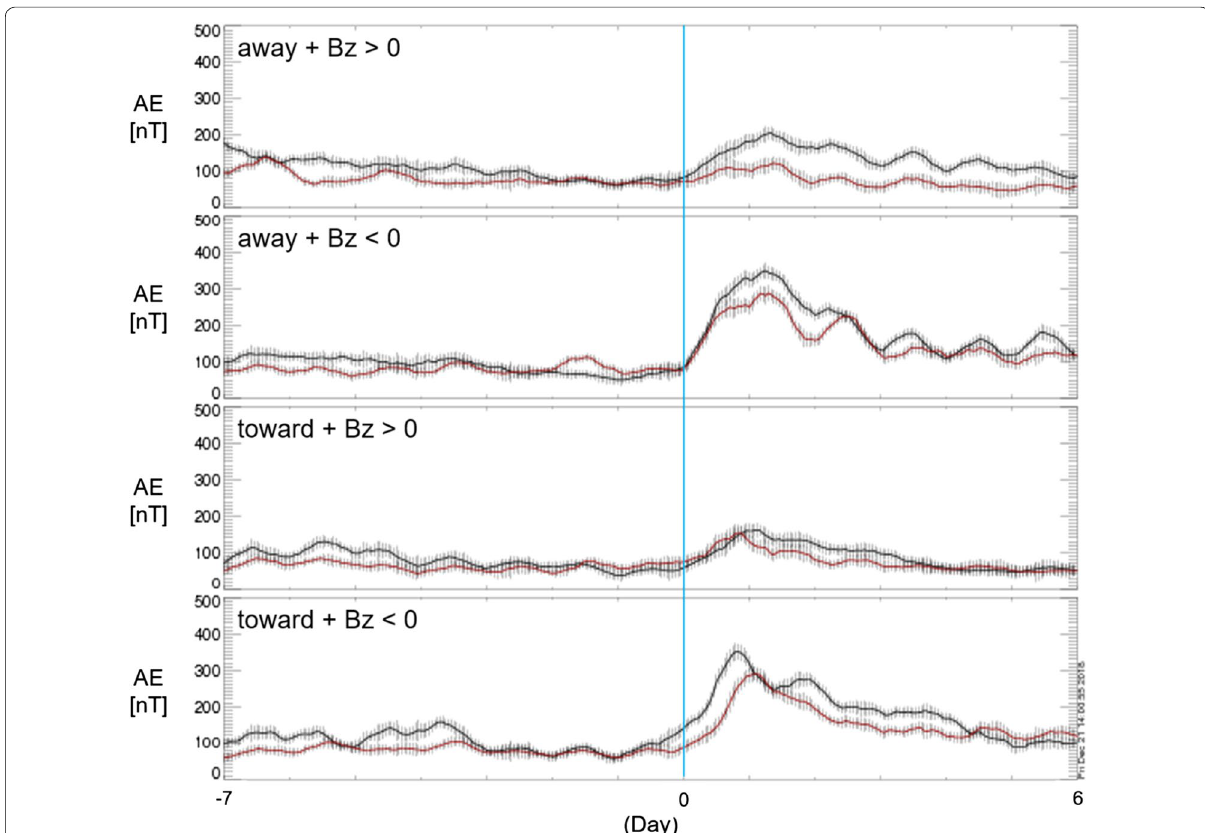
Fig. 11 The variation of AE index for IMF cases for solar cycle 23 (black line) and for cycle 24 (red line). The vertical light blue line represents the start time of an enhancement of solar wind velocity around the Earth’s orbit. The error bar represents the standard